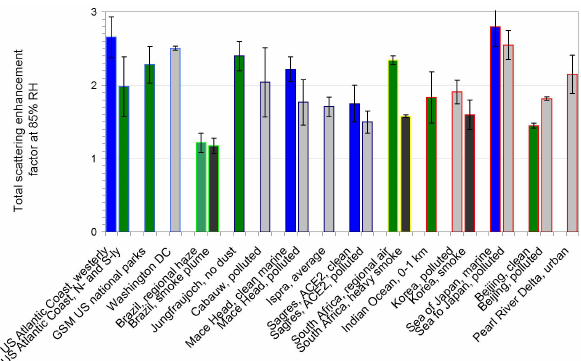
Fig. 8. Scattering enhancement factor between 20–30% and 85% RH from various sites (see references in Sect. 4.2.4).